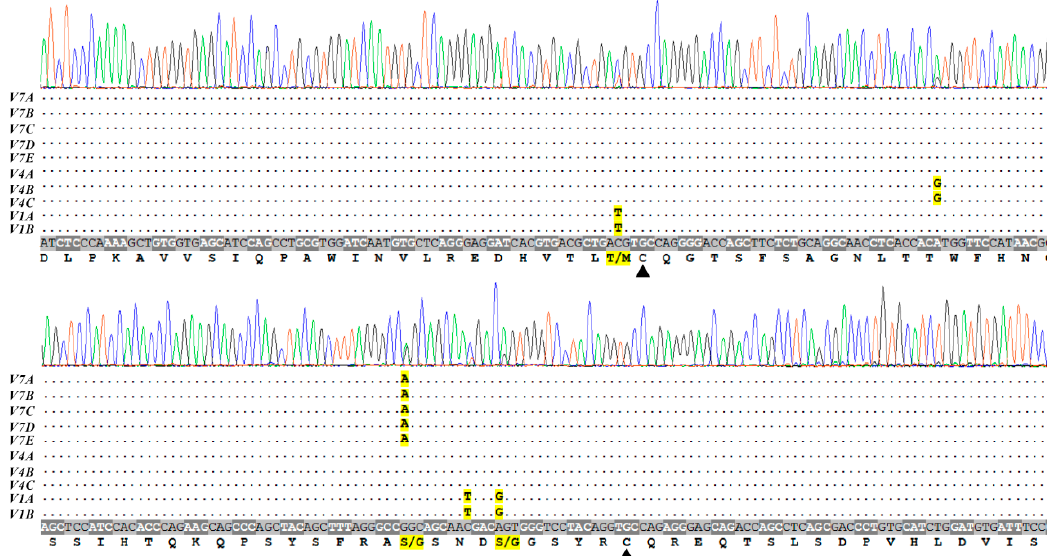
Figure 4. Sequence chromatograms of CD32 third exon of a representative Holstein sire compared to an allele model based on DNA-Seq. DNA extracted from semen was used for simultaneous PCR amplification of the third exons encoding CD32. Chromatograms show five variations in which the ratio of nucleotide heights provided information on the number of encoding paralogs. Below the chromatogram, dots indicate similarity to the consensus sequence of 10 allele variants predicted by the assembled sequences and counts of this sire’s DNA-Seq reads. Putative amino acid translation is given below the consensus sequence, in which codons are annotated by alternating font and background color. Nucleotide and amino acid variations are highlighted in yellow. Arrowheads point to the two cysteines predicted to form the disulfide bond that stabilizes an extracellular structure of the immunoglobulin-like C-2 type.